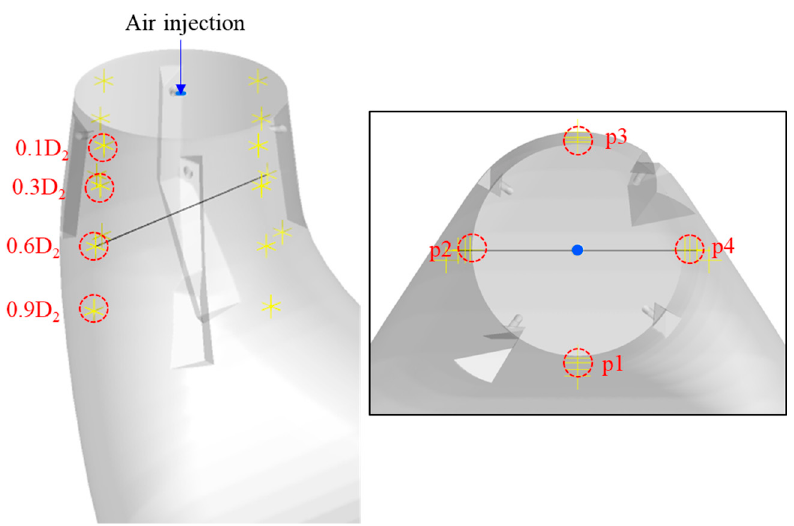
Figure 3. Pressure measurement points in the DT with the air-injection inlet of the Francis turbine model.